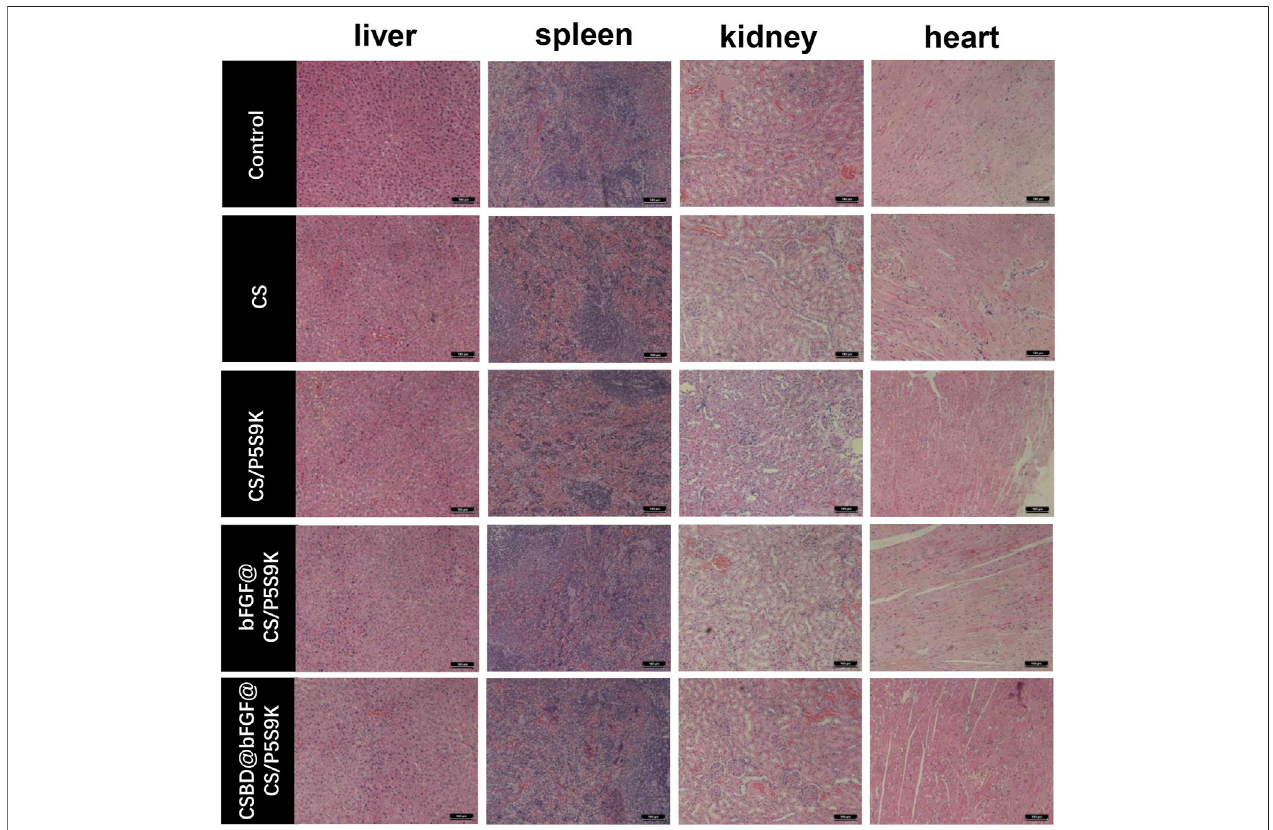
FIGURE 10 | At day 12 post operation, H&E was used to stain sections of important organs (liver, spleen, kidney and heart) in experimental animals.